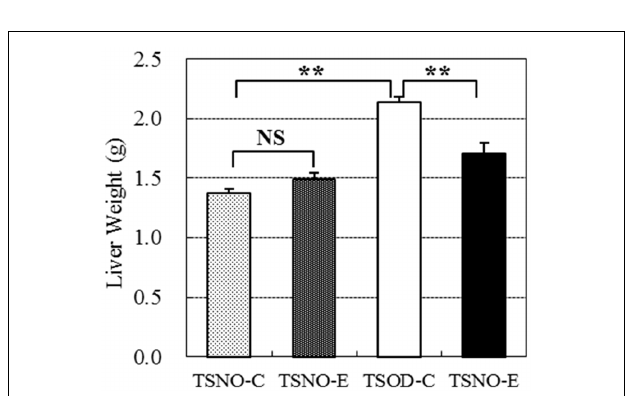
FIGURE 5 | Size of each adipocyte. (A–D) represent HE-stained epididymal adipose tissue section derived fromTSNO-C,TSNO-E,TSOD-C, andTSOD-E